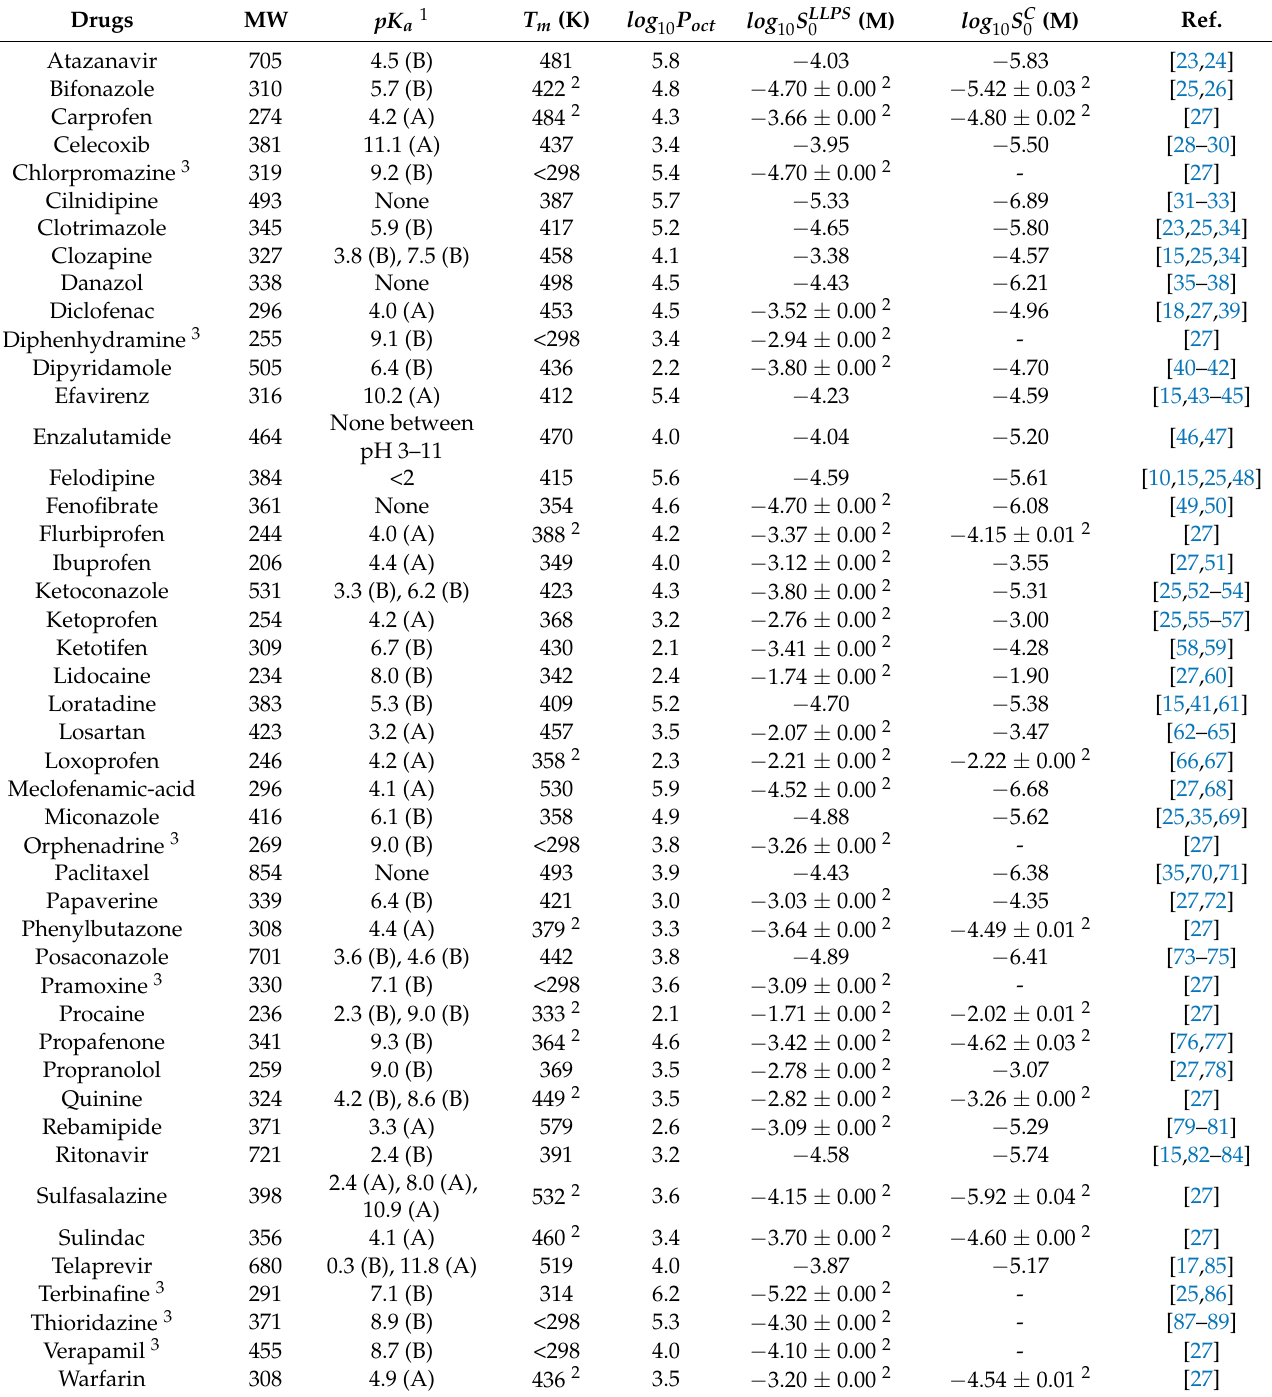
, and S C of model 0 0